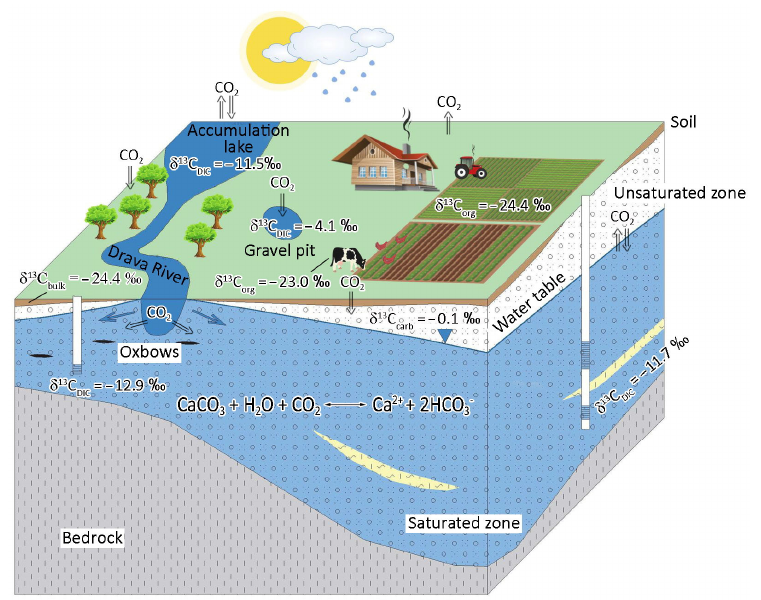
Figure 7. A conceptual 3D block diagram presenting a conceptual model of the critical zone in the Varaždin SW ‐ GW